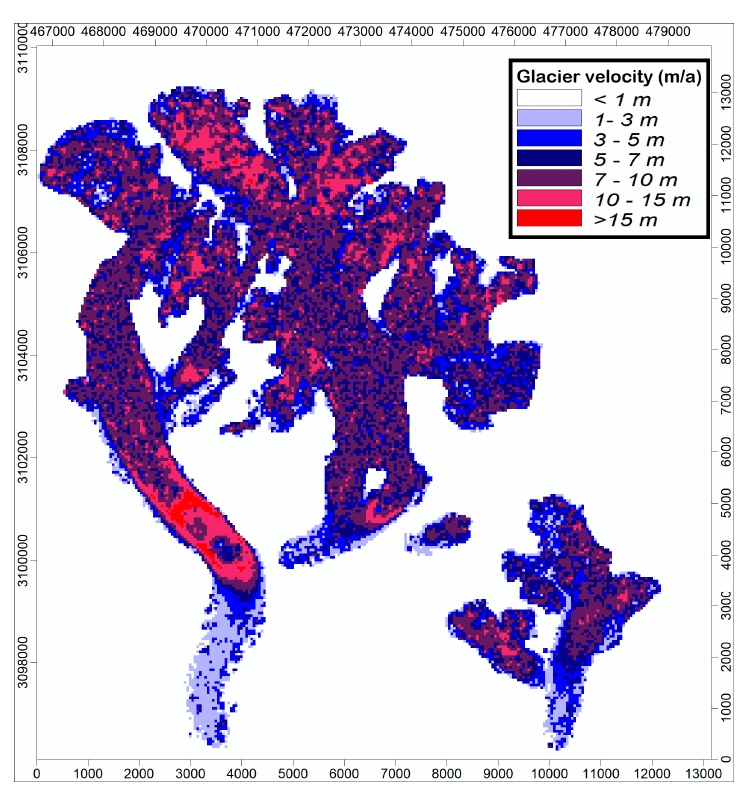
Figure 17. Annual surface displacement on Ngozumpa glacier, normalized values based on the autumn 2015 and spring 2016 acquisitions. UTM 45 N.